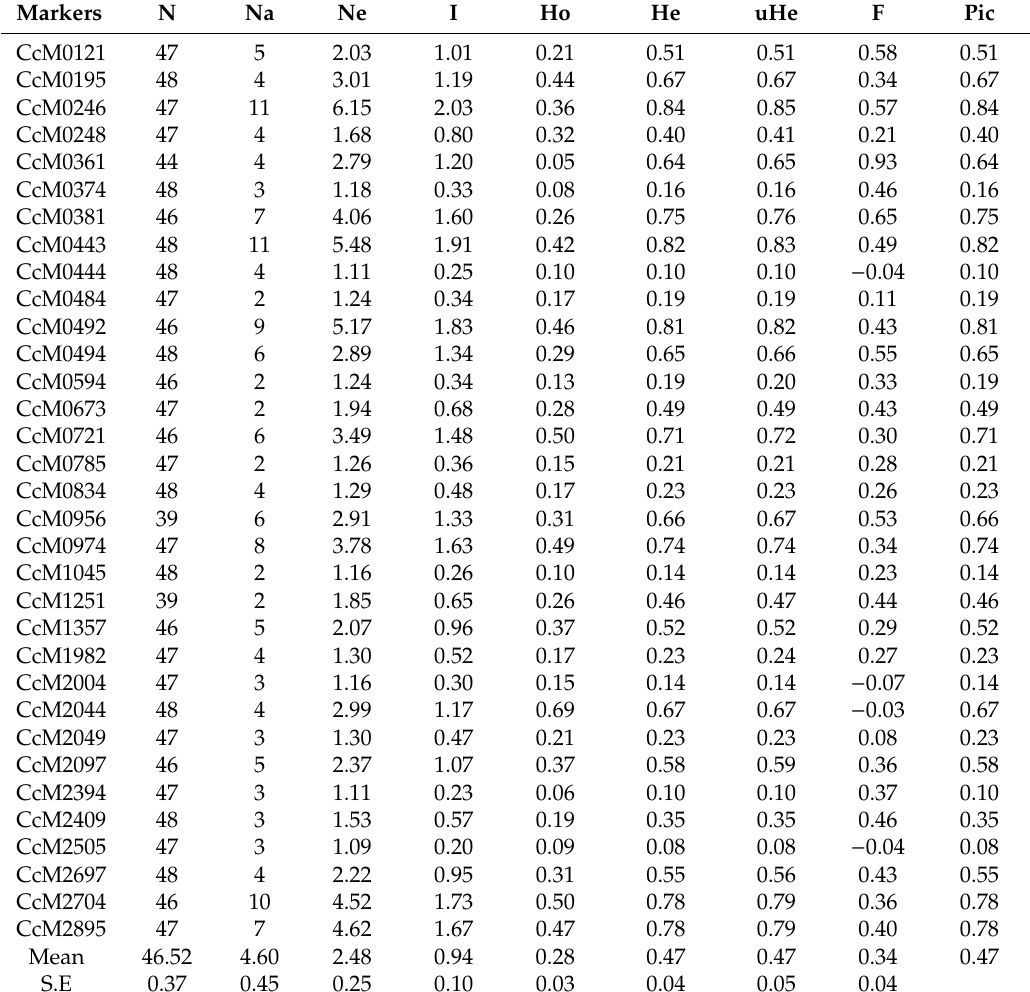
Table 3. Genetic parameters generated by 33 SSR markers on 48 pigeonpea